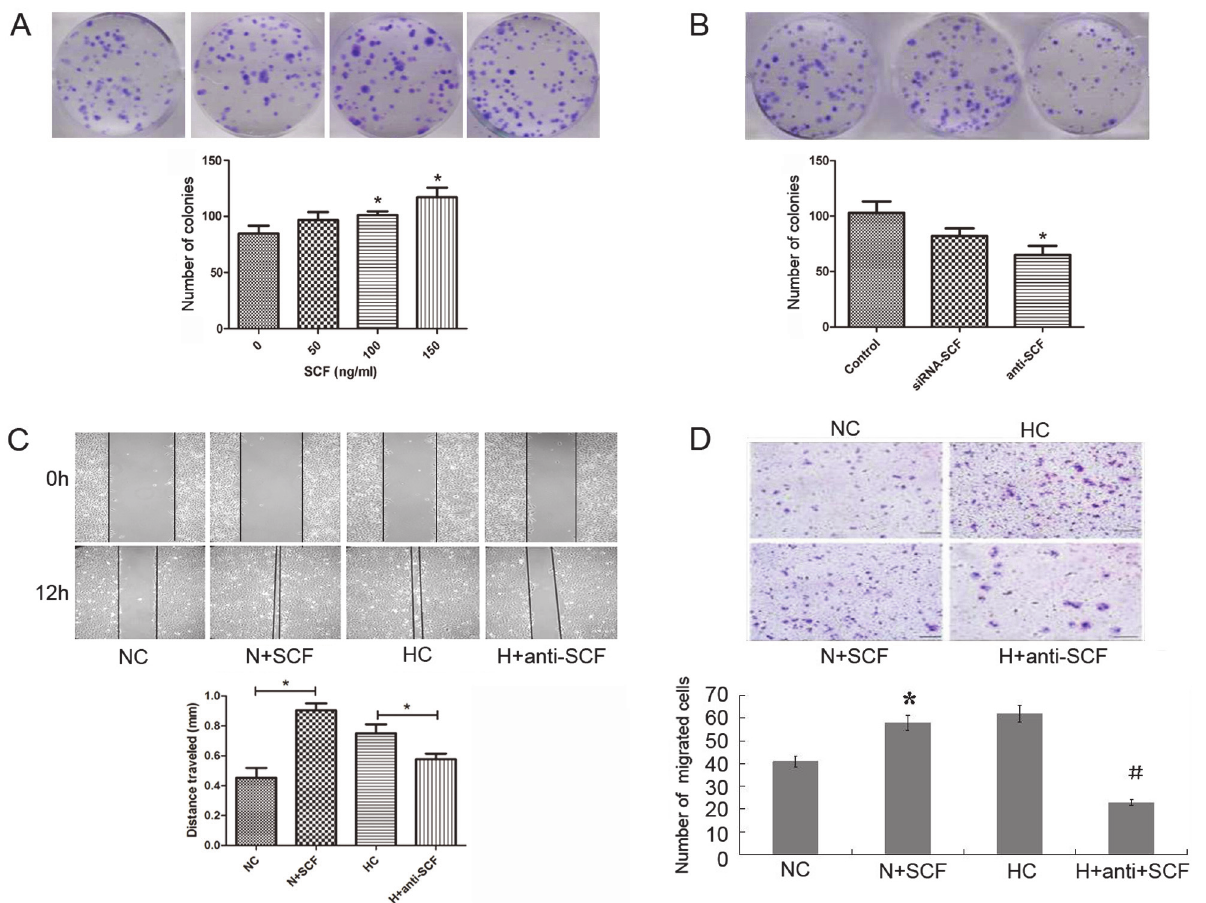
Fig 4. Influence of SCF on the biological behavior of PDAC cell. (A) and (B): Colony formation results showed the SCF effect on cell proliferation. After applying the interference of exogenous SCF or anti-SCF antibody in PANC-1 cells, the proliferative ability in the interference groups significantly increased or decreased compared with those of the control groups (p < 0.05, respectively). * stands for p < 0.05 (mark group VS control group). (C): The scratch results showed the SCF effect on cell invasion. After the interference of exogenous SCF and anti-SCF antibody, the widths in the SCF or anti-SCF groups were smaller or bigger than those in the NC or HC control group (p < 0.05, respectively). (D): The transwell chambers results showed the SCF effect on cell invasion. After the interference of exogenous SCF or anti-SCF, the cell number through the membrane was significantly more or less than the control group (p < 0.05, respectively). * stands for p < 0.05 (N+SCF group VS NC group), and # stands for p < 0.05 (H +anti-SCF group VS HC